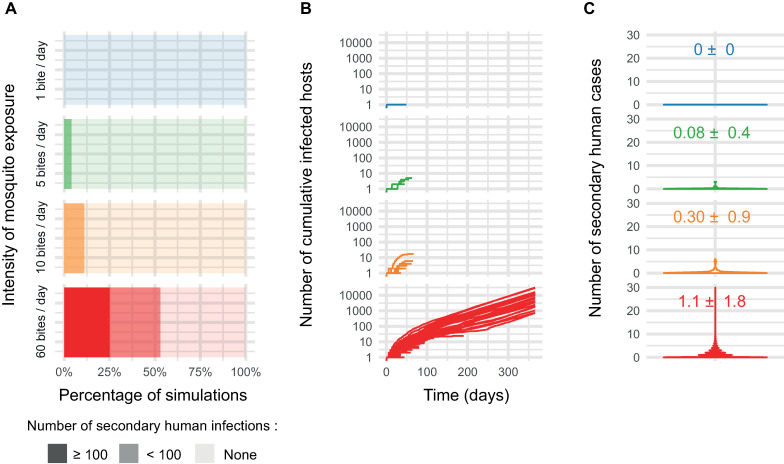
ZIKV outbreak simulations results according to levels of mosquito bites exposure and the consideration of the dose-dependent intra-mosquito ZIKV dynamic.Stochastic agent-based epidemiological simulations considering within-host infection dynamics on transmission probability during mosquito-human infectious contacts were performed in 100 independent replicates. A total of 4 mosquito bite intensity levels were tested: 1, 5, 10, and 60 bites per human per day. (A) Stacked proportions of outbreaks resulting in no secondary infected human host, infected human hosts < 100 and infected human hosts ≥ 100. (B) Cumulative number of infected humans over time. Each curve represents a simulation run. (C)- Violin plots showing the number of secondary cases values densities for each condition. Mean number of secondary cases ± Standard Deviation (SD) is represented in each panel.